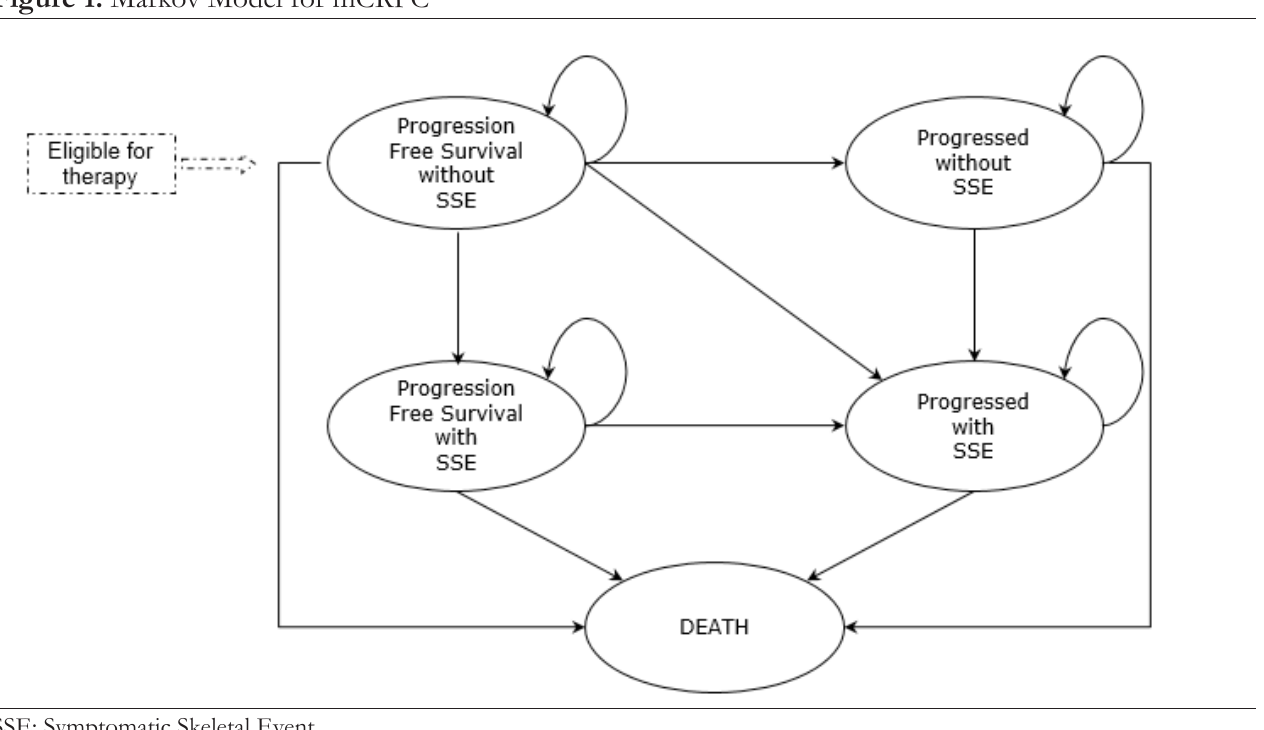
SSE: Symptomatic Skeletal